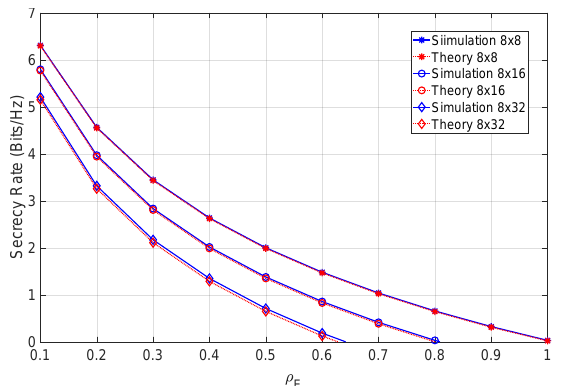
Figure 9. Secrecy rate of the system for various numbers of eavesdroppers, at 12 dB SNR.